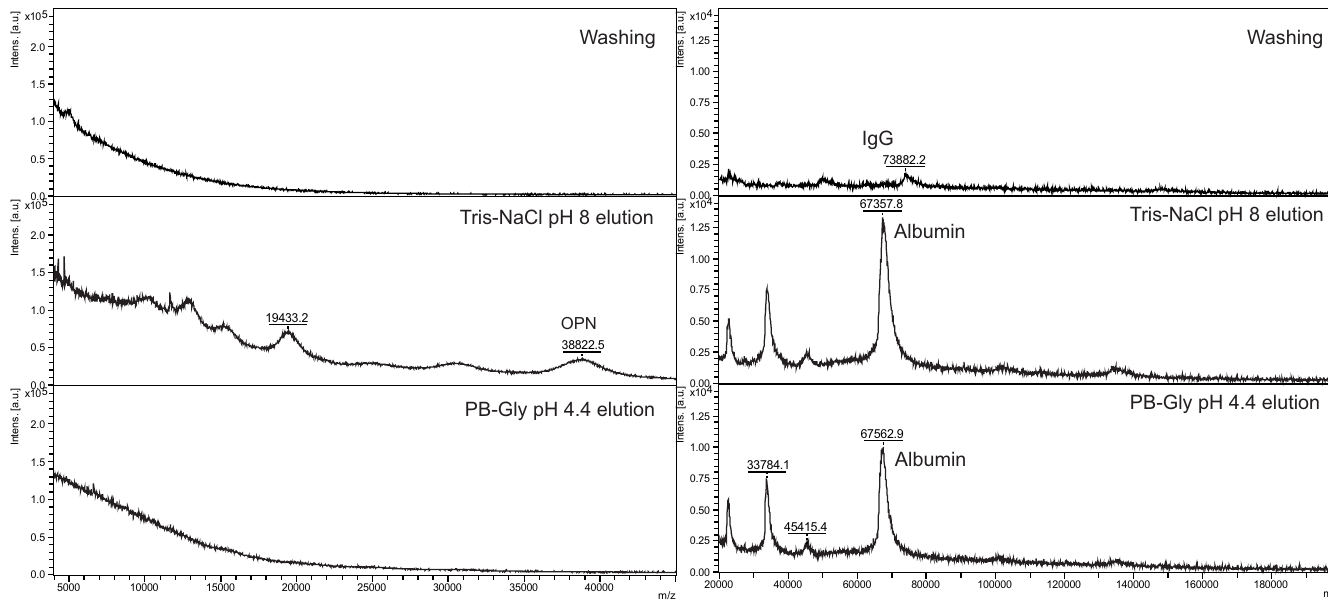
Fig 4. MALDI-MS of proteins in different extraction fractions using DEAE-CB. Left: rhOPN (200 μ g/mL). Right: protein mixture (BSA 40 mg/mL, IgG 10 mg/mL, rhOPN 200 μ g /mL).